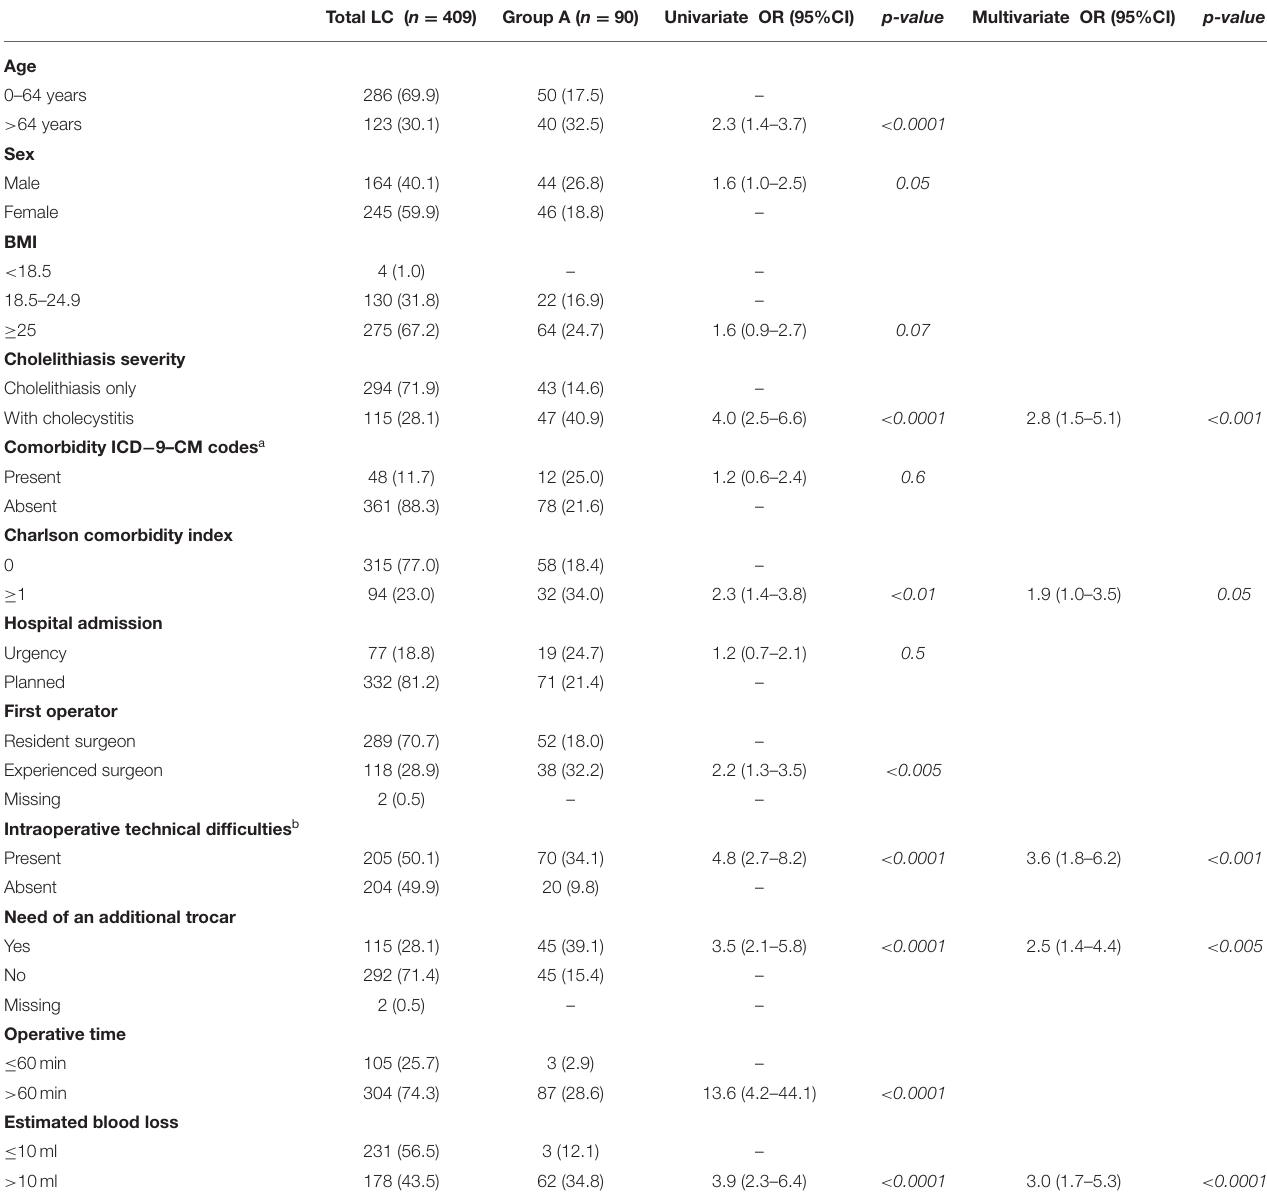
TABLE 3 | Univariate and multivariate analysis for drain placement after